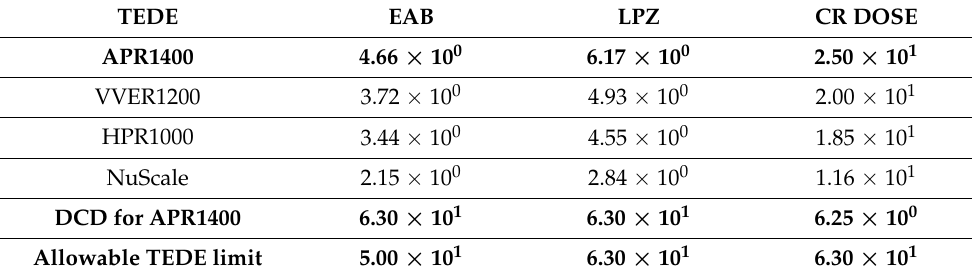
Figure 5. FHA TEDE comparison of exclusion area boundary, low population zone, and main con- trol room. Table 5. Comparison of FHA Analysis using verified DCD results [23]. Table 5. Comparison of FHA Analysis using verified DCD results [23].